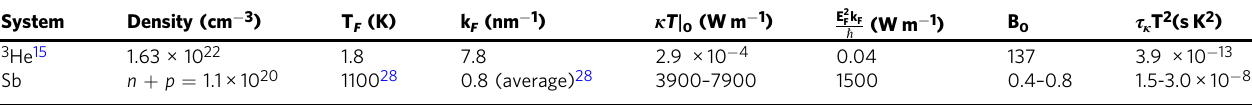
Table 2 Comparison of two Fermi